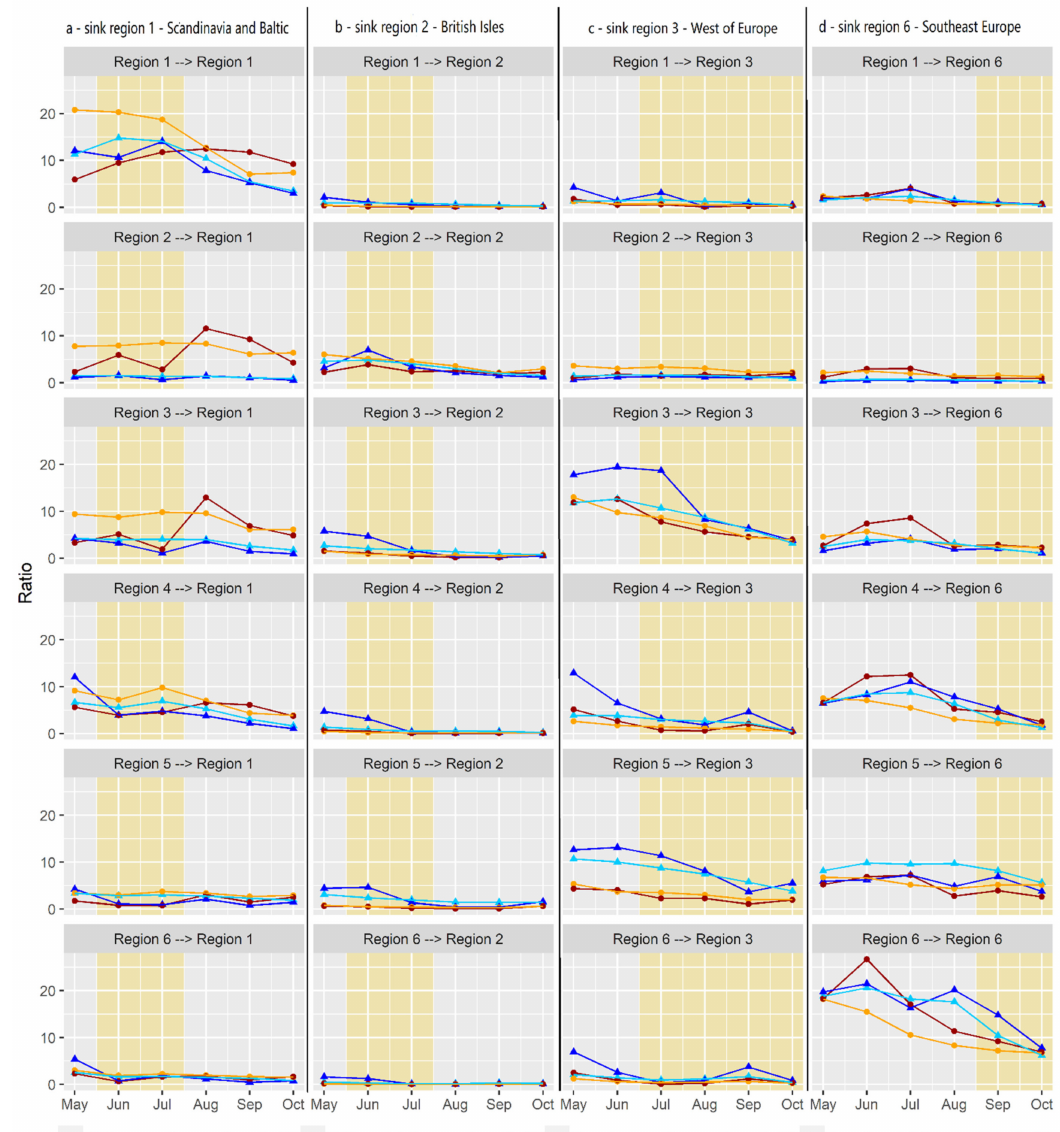
Figure 6. The 2018 monthly evaporation export and precipitation import ratios of ( a ) regions 1 ( b ) region 2, ( c ) region 3 and ( d ) region 6 in comparison with the climatology (2000–2018) of monthly evaporation export and precipitation import ratios. A yellow shading is applied when the month experiences drought (i.e., SMC of that month and NDVI of the following month percentiles <33.4). The location of the regions is given in Figure